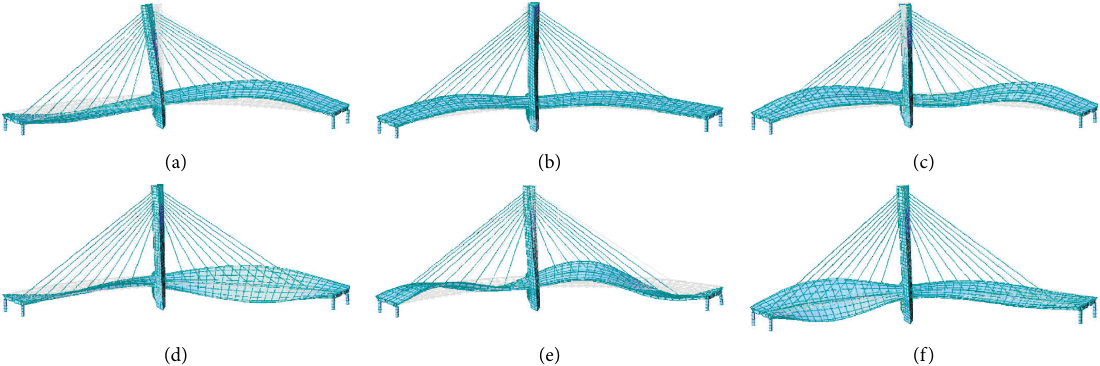
Figure 10: Selected vibration modes of the FE model of the Marghera bridge. (a) f f FEM � 1.20 Hz (B3). (d) f FEM � 1.30Hz (T1). (e) f FEM � 1.59Hz (M1). (f) f FEM � 1.65Hz